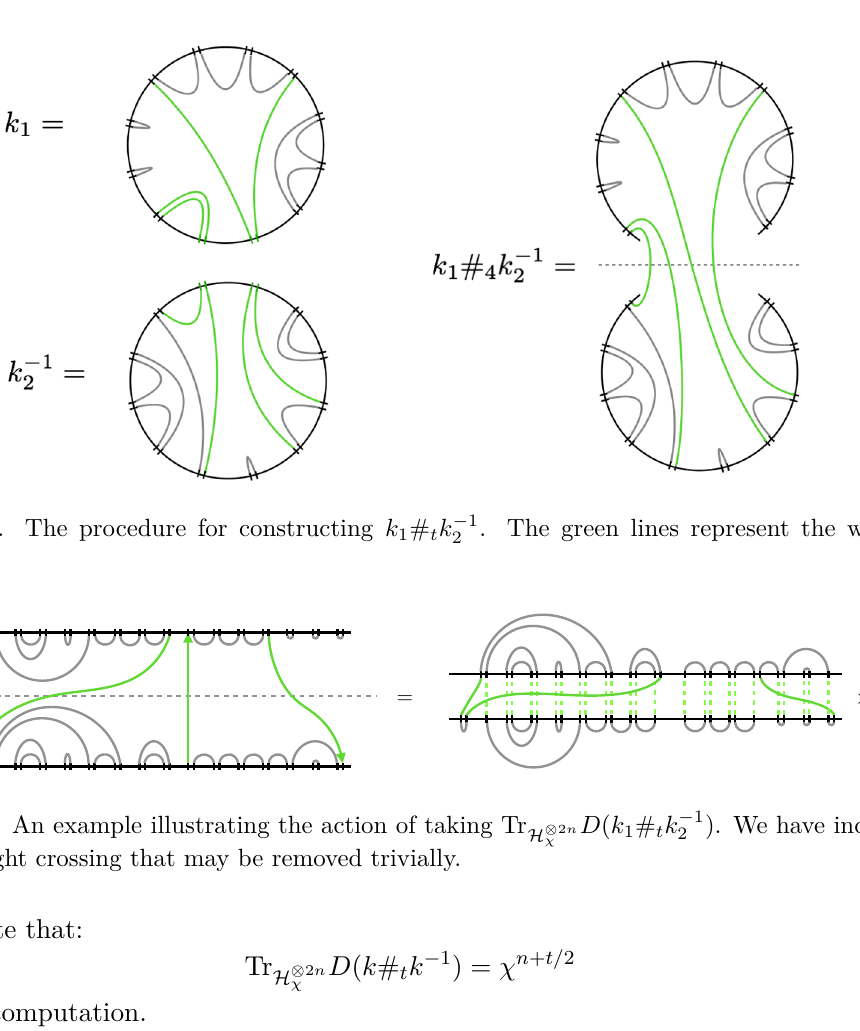
Figure 26 . An example illustrating the action of taking Tr single straight crossing that may be removed